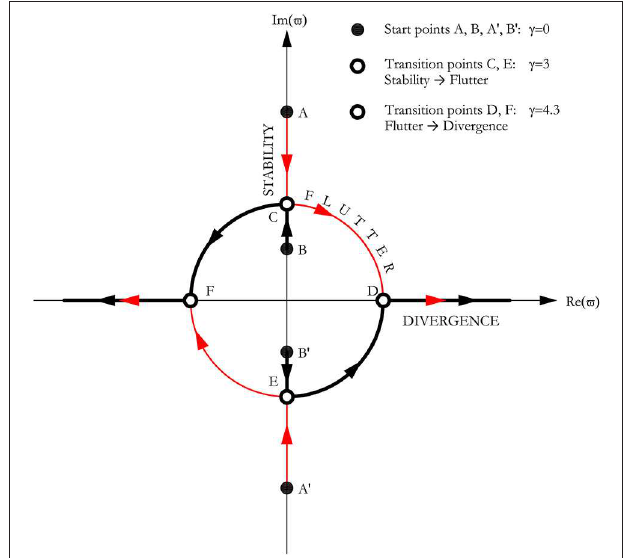
FIGURE 9 | Real (solid line) and imaginary (dot line) parts of the eigenvalues vs. dimensionless follower load γ , for v